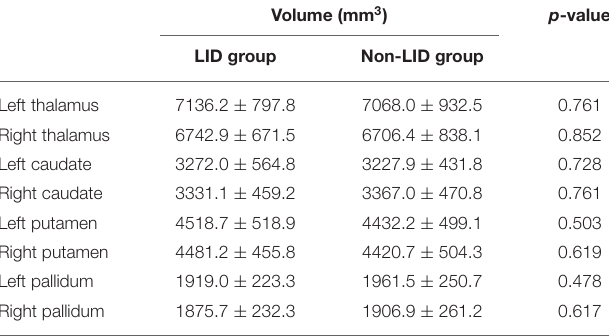
TABLE 2 | Group-wise differences in the volumetric features of eight subcortical